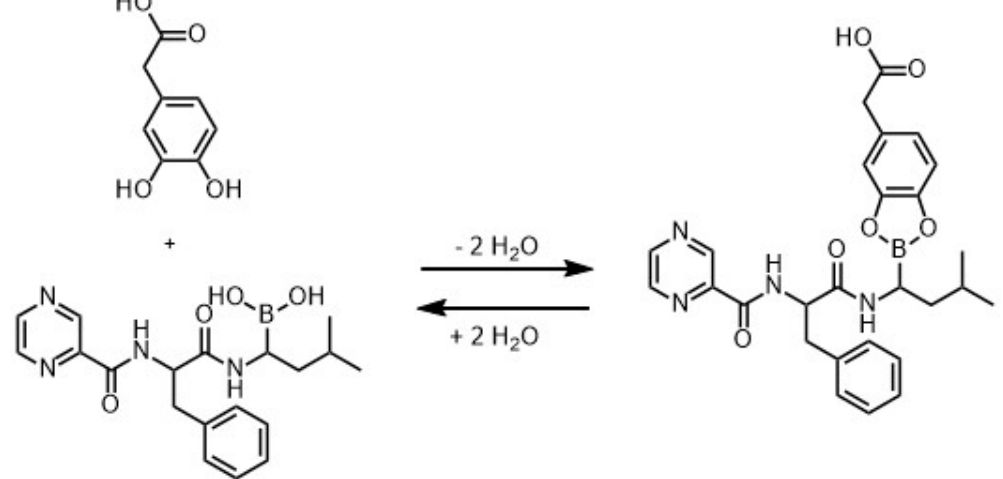
Figure 3. Reversible covalent interaction (esterification) between the drug BZM and catechol containing DOPAC.